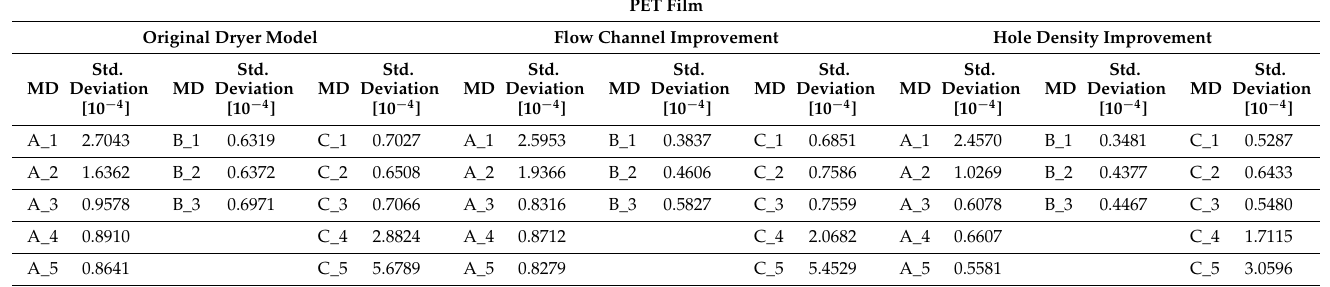
Table 4. Standard deviations of the strain distributions of the PET and PI films in the dryer. PET